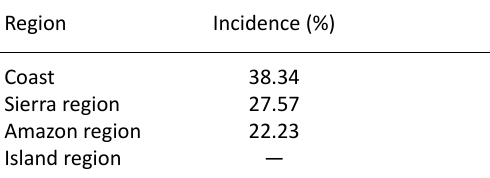
Table 3. Summary of Incidence media values